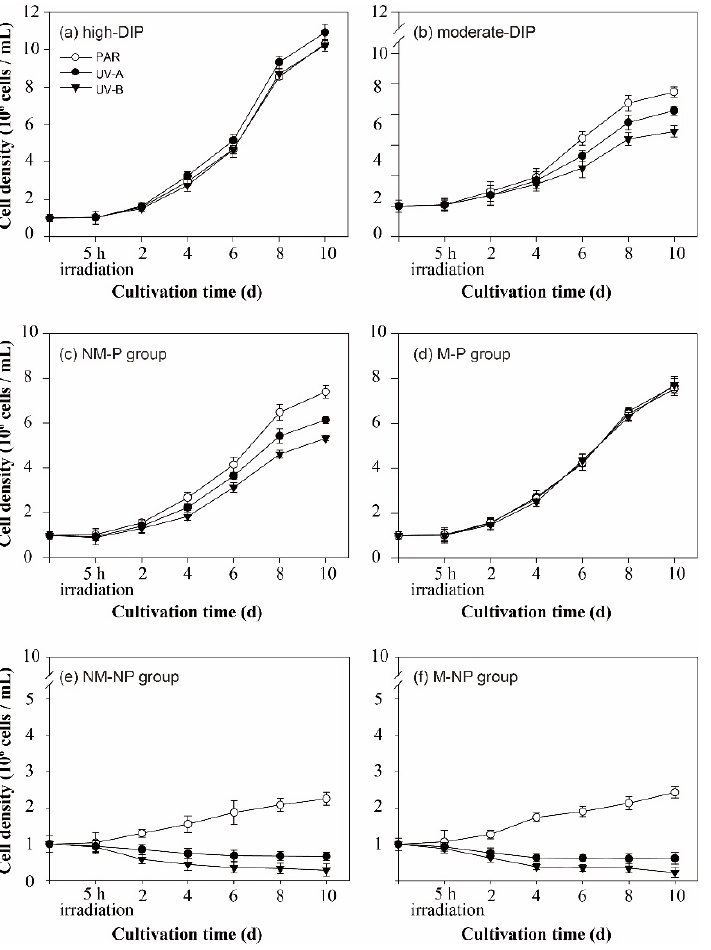
Figure 1. Effects of different irradiation on the growth of M. aeruginosa in ( a ) high-DIP medium, ( b ) moderate-DIP medium, ( c ) NM-P group, ( d ) M-P group, ( e ) NM-NP group and ( f ) M-NP group .